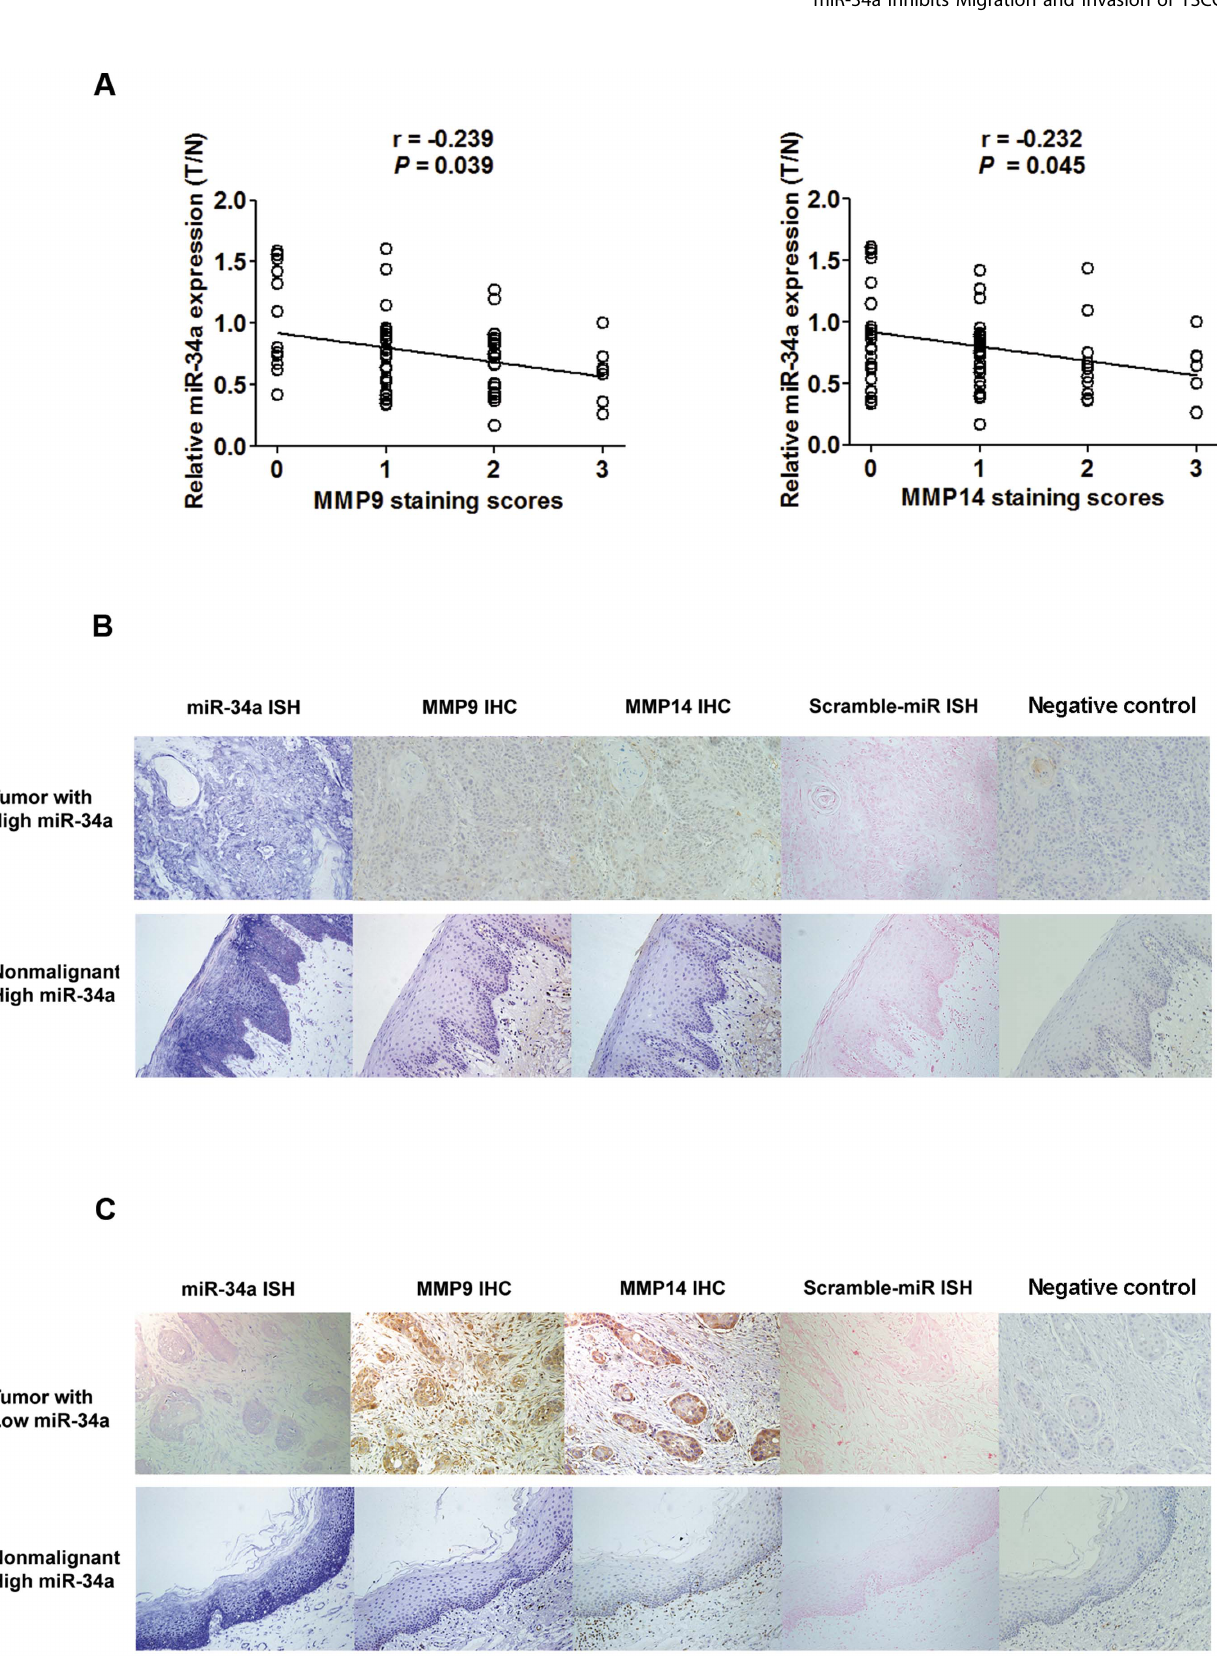
Figure 4. Inverse correlation between miR-34a and MMP9 or MMP14 protein levels in TSCC. The expression of MMP9 or MMP14 proteins was examined by immunohistochemistry (IHC) and miR-34a expression was detected by qRT-PCR and in situ hybridization (ISH). (A), Statistical analysis of the expression of miR-34a in tumor vs. nonmalignant tissue. Spearman’s rank correlation analysis was performed, with r and P values as